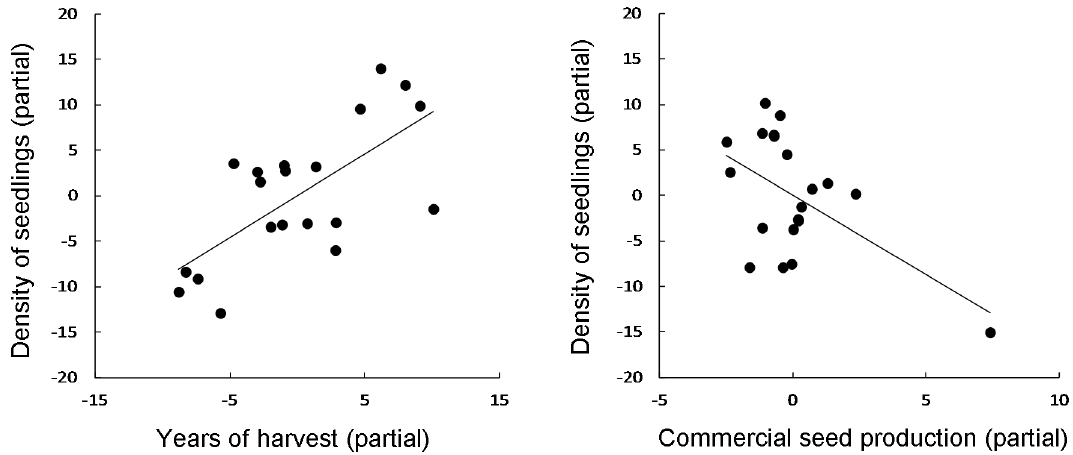
Figure 2. Multiple regression analysis testing the effect of Brazil nut harvesting intensity on the density of seedlings. The partial regression to the left shows the relationships between density of B. excelsa seedlings (DS) and years of harvest (YH), and the partial regression on the right shows the relationship between density of seedlings and commercial seed production in tons (PR) in B. excelsa groves in the Kayapo´ Indigenous Land, southeastern Amazonia. The points in each graph represent the 20 B. excelsa groves sampled. The full multiple regression model has R 2 =0.576.